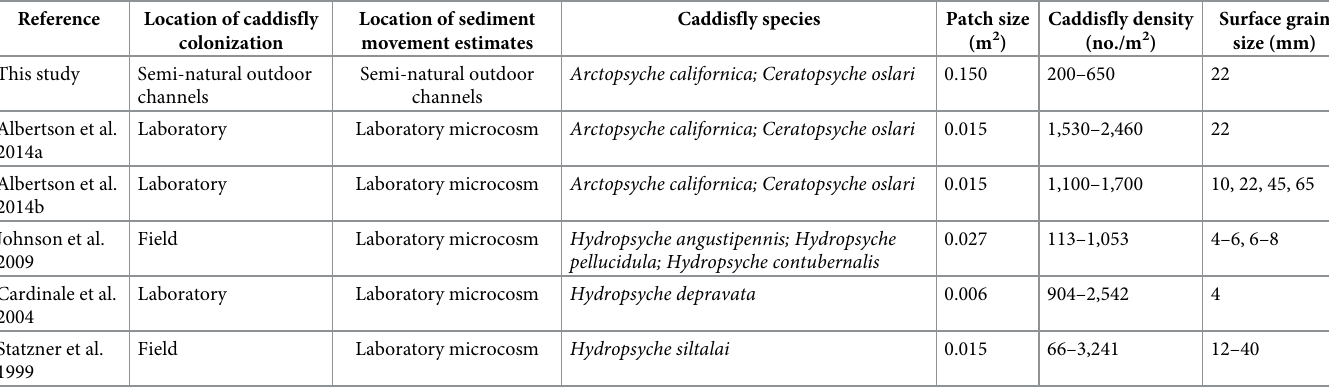
Table 1. Description of related